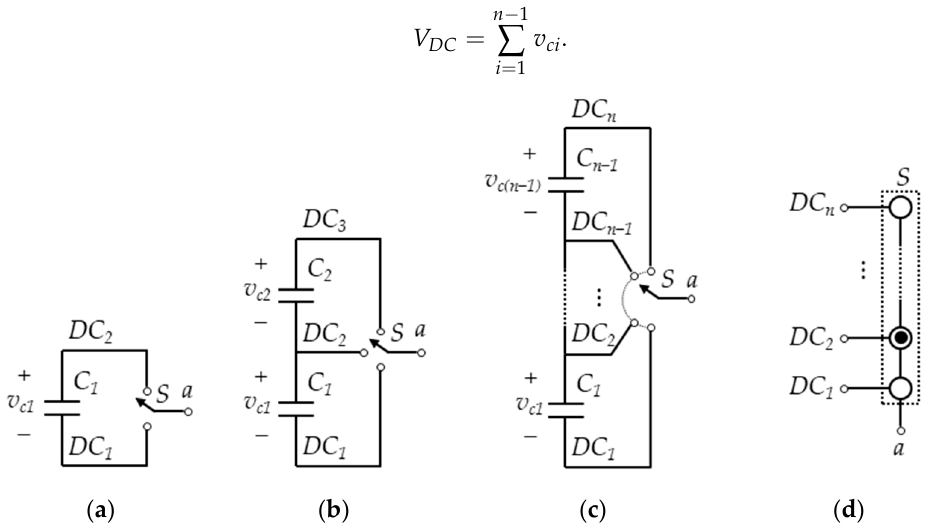
Figure 1. Functional schematic for one leg of a NPC converter. ( a ) Symbol 1, two levels. ( b ) Symbol 1, three levels. ( c ) Symbol 1, n levels. ( d ) Symbol 2, n levels, where the output a is connected to the neutral point DC 2